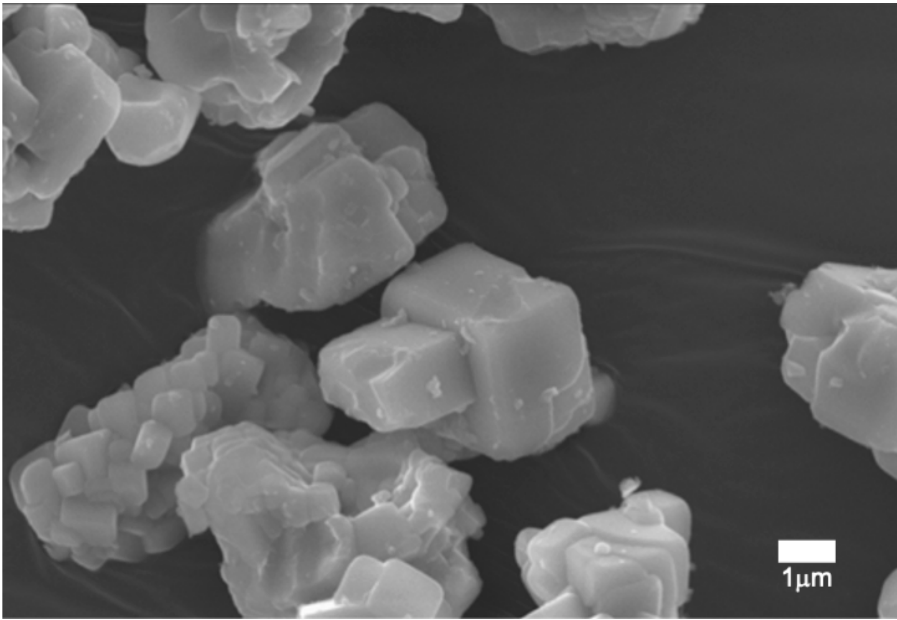
Figure 13. SEM micrography of pigment Y 0.98 Al 0.98 Cr 0.04 O 3 fired at 1500 °C.